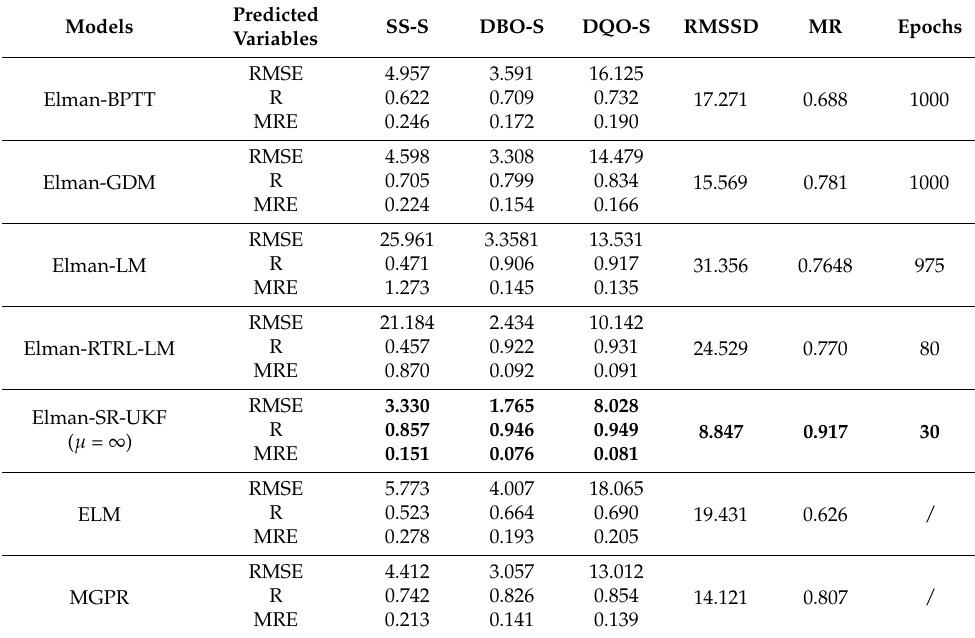
Table 3. RMSE, R, RMSSD, MR, and epochs values of the output